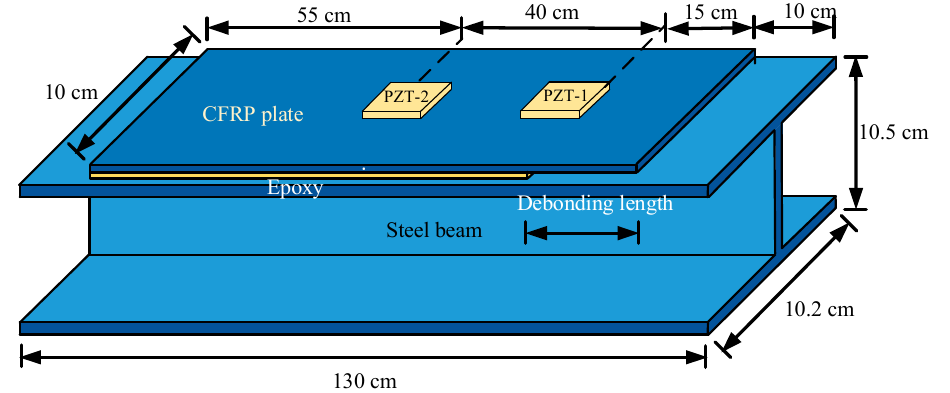
Figure 4. Specimen with CFRP plate debonding state.